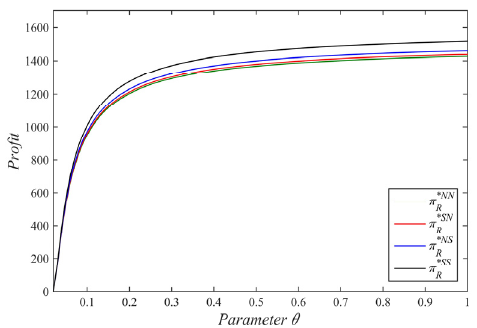
Figure 12. The impact of parameter